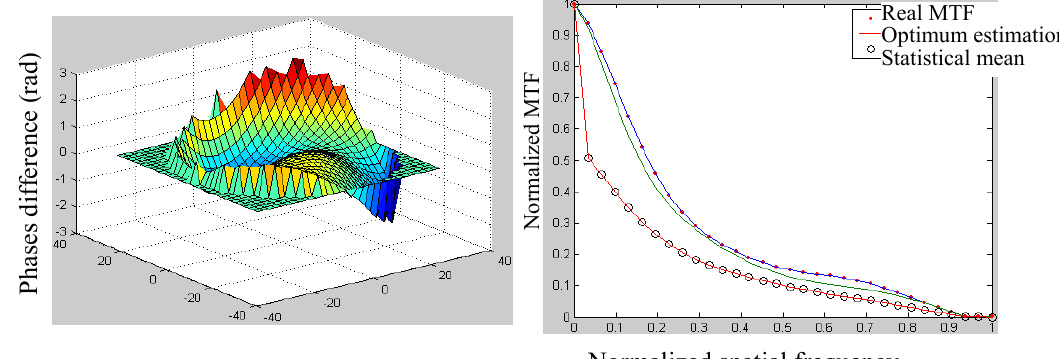
Figure 6. The difference between initial Figure 7. Real ,the best estimated and and estimated phases(left). mean MTF in10 simulations